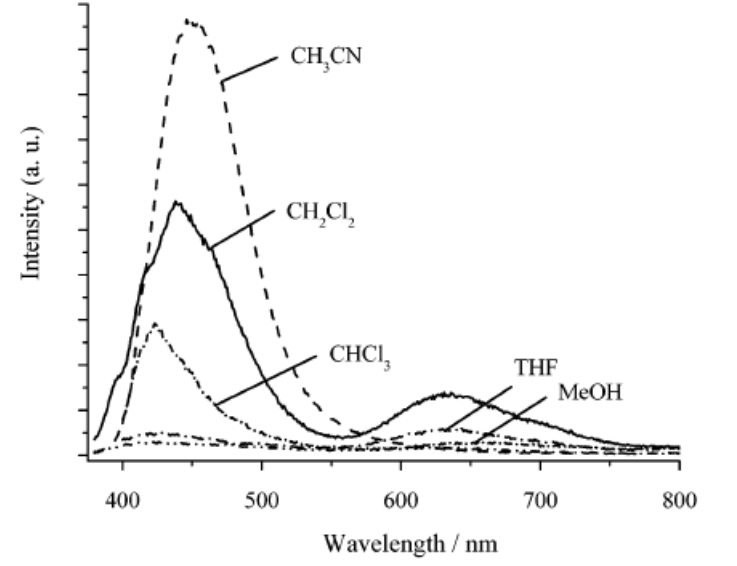
Figure 4. Emission spectra of {[(8-QNS) solvents at 298 K. Complex concentration = 9 × 10 –5 M. Excitation is at 320 nm. Reproduced with permission from